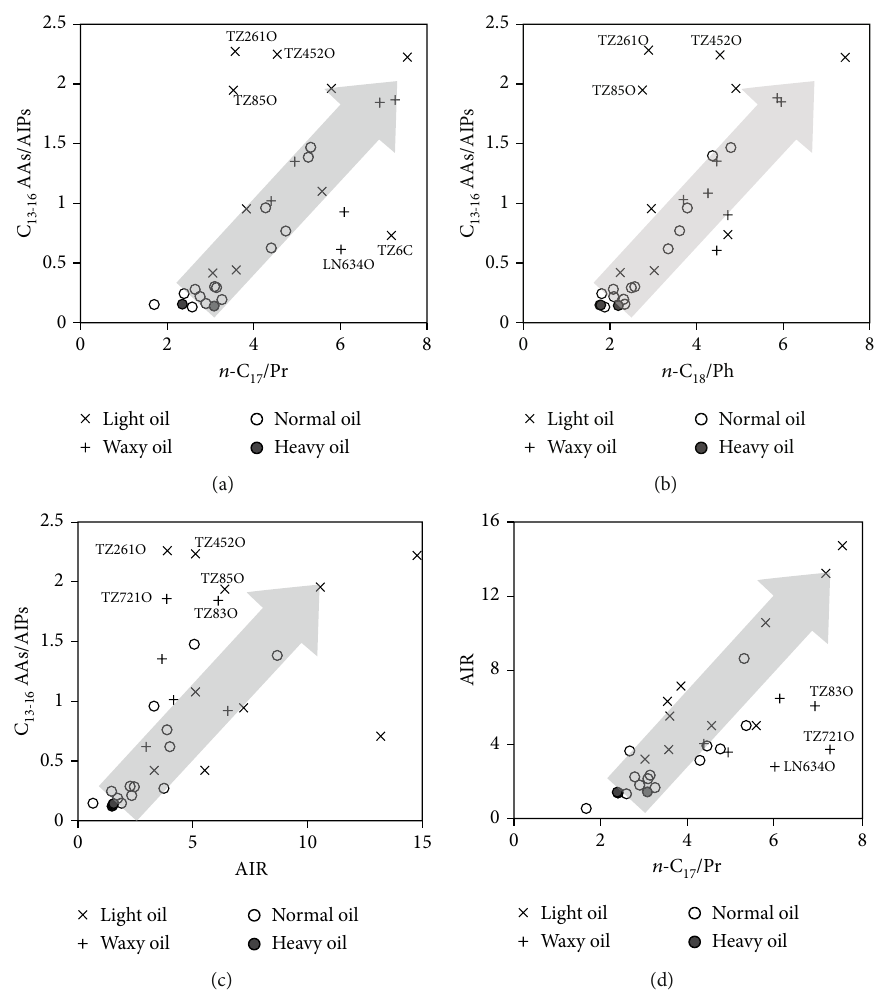
Figure 7: Cross plots of C